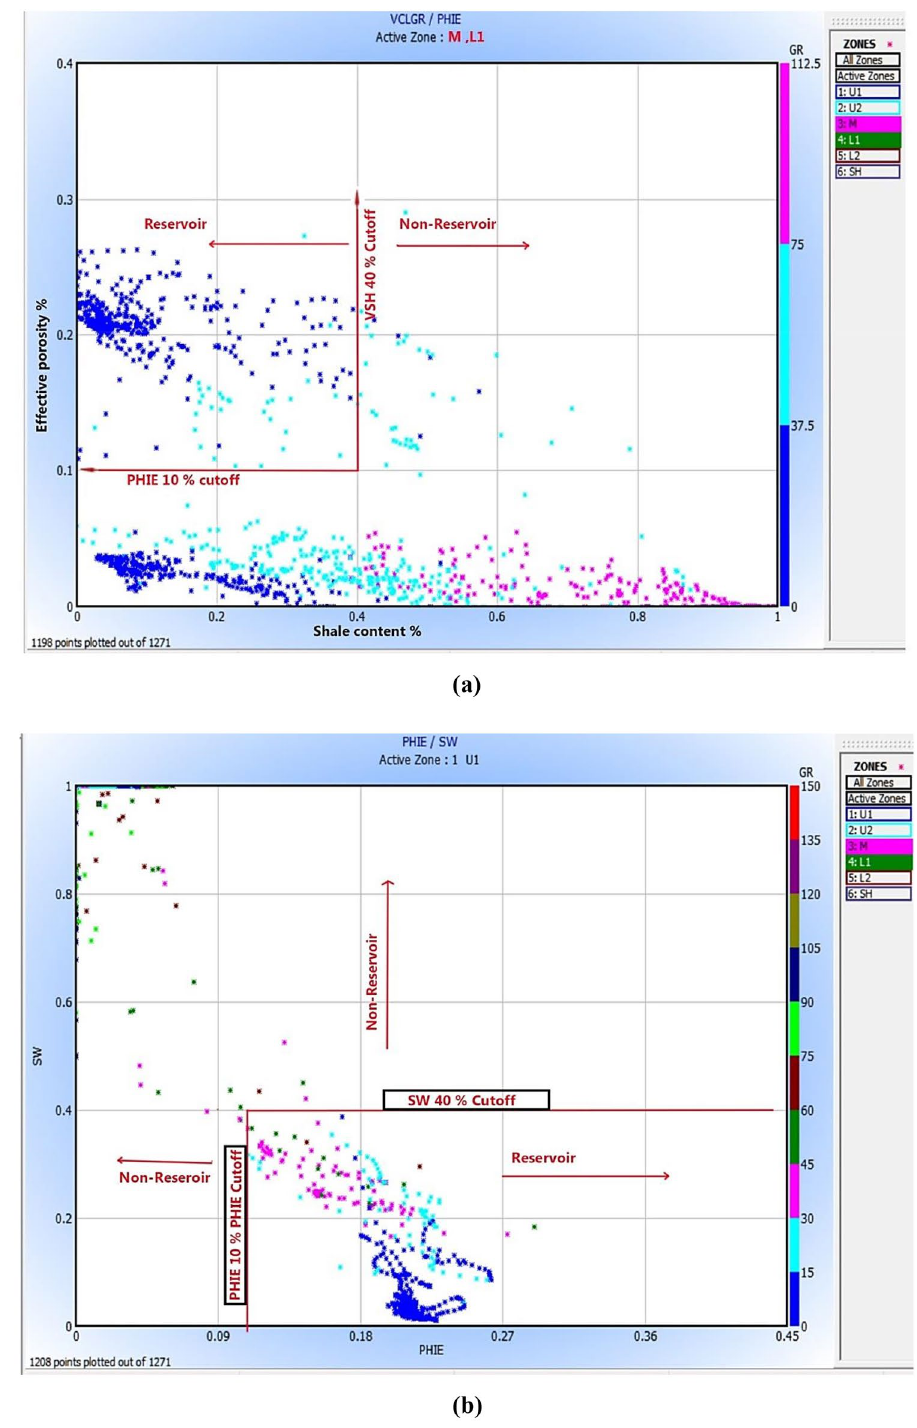
Fig. 8 Discriminating the reser- voir and non-reservoir intervals in A-14 well using a the shale content-effective porosity cross- plot and b the effective porosity (Phie)-water saturation (Sw) cross-plot for A-14 well. The colored bar to the right indicates the gamma-ray values